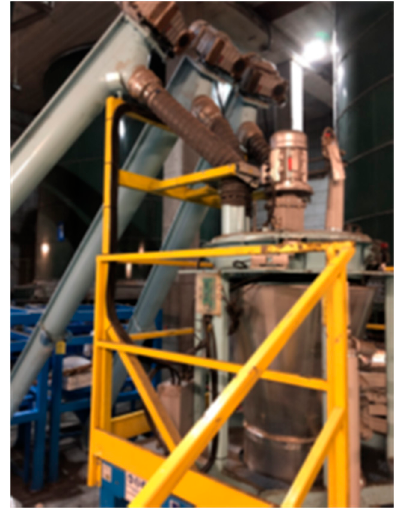
Figure 1. Pilot plant built at Municipal Solid Waste Incineration MSWI plant.